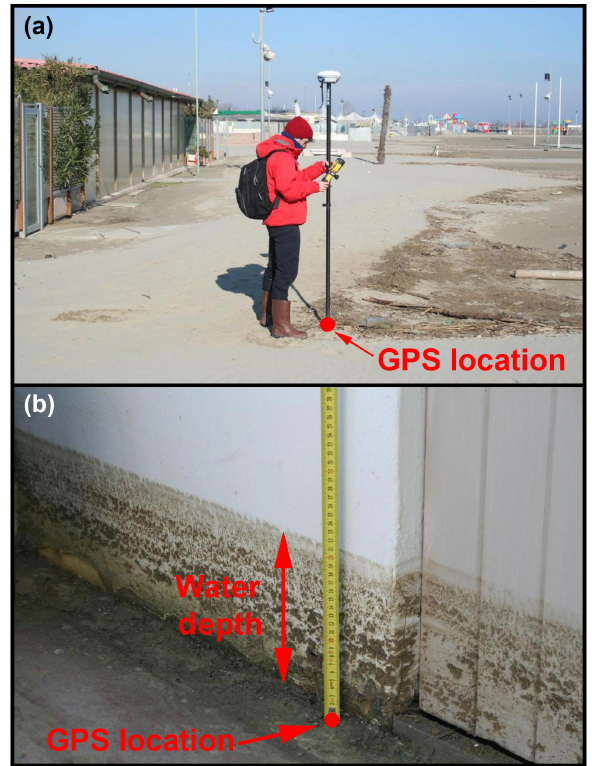
Figure 4. Examples of GPS floodline (a) and GPS flood mark (b)